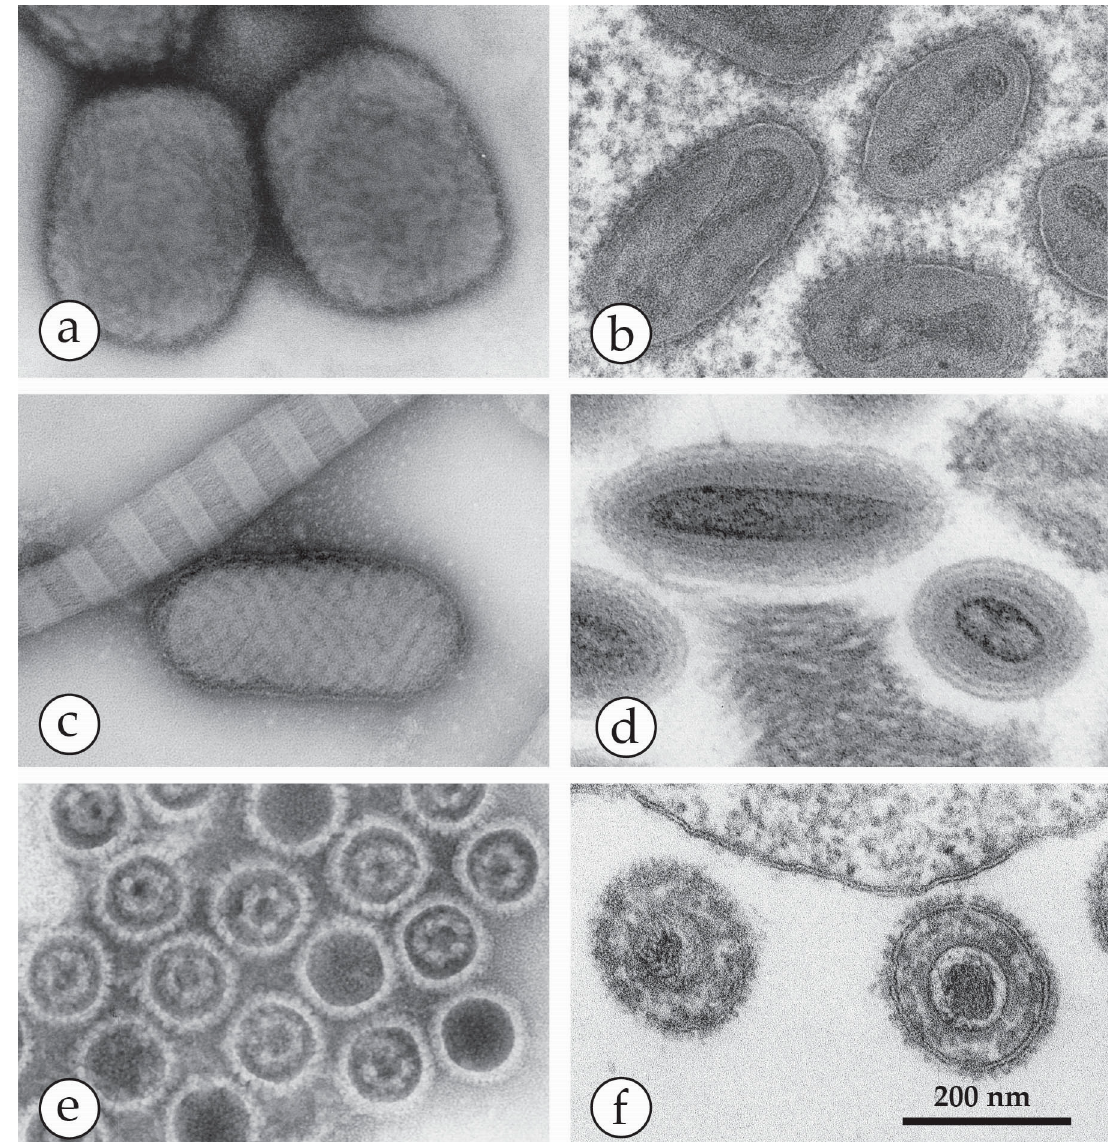
Figure 13. A comparison of OPV, PPV and herpesviruses after NS- (left) and TS- (right) preparation and DEM: ( a ) NS-DEM using UAc of a suspension of ectromelia OPV showing “brick-shaped” particles, 250 × 350 nm in size, with an irregular pattern of short, 10–15 nm surface protrusions. ( b ) TS-DEM of OPV from a diagnostic CAM from the last smallpox case in Germany [30]. Within the sections through the virions, inner components, the dumbbell-shaped core and lateral bodies can be seen. ( c ) NS-DEM of PPV observed in a diagnostic biopsy after grinding and NS with UAc. The ovoid virion is surrounded by parallel-running surface threads and lying beside a thick thread of collagen with its typical 67 nm-periodicity. The case was diagnosed later as a zoonotic infection of a butcher by bovine papular stomatitis virus. ( d ) TS-TEM of PPV observed in the biopsy from the same case as ( c ). In longitudinal section planes, PPV appear slimmer than OPV and they also lack the prominent lateral bodies of OPV. ( e ) NS of herpes virus capsids, showing occasionally a roughly hexagonal outline. The electron-translucent portions inside the core contain nucleoproteins associated with the viral DNA. ( f ) TS-TEM of a diagnostic culture showing two virions of equine herpesvirus (EHV-1). The envelope is studded with fuzzy surface projections. Underneath the lipid bilayer the ill-defined tegument and the slightly angular cores are seen. The latter contains the electron-dense viral genome.